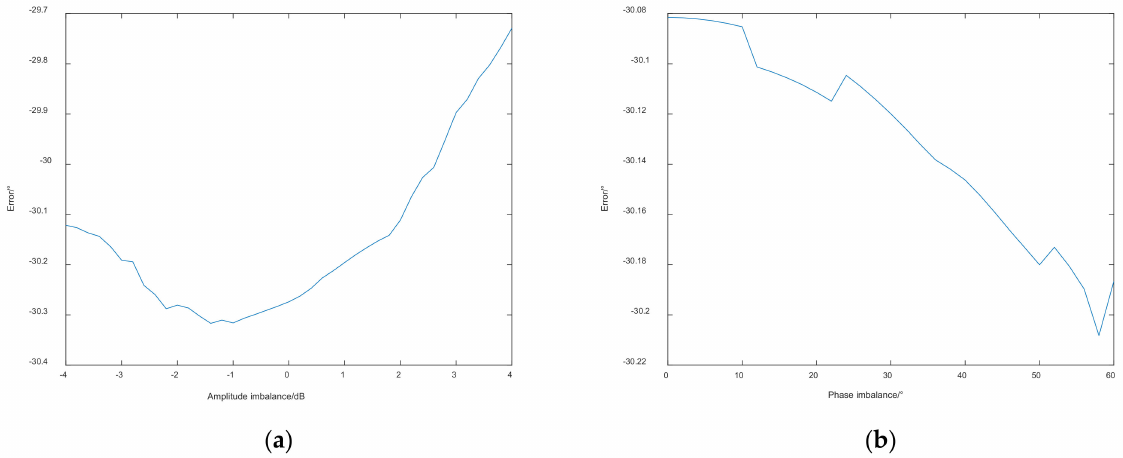
Figure 9. ( a ) Influence of amplitude imbalance on PolInSAR phase. ( b ) Influence of phase imbalance on PolInSAR